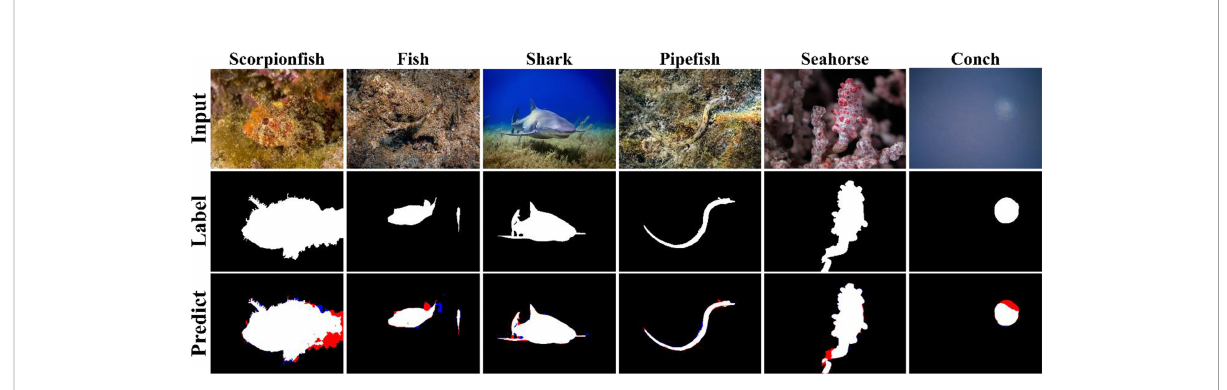
FIGURE 6 Result images of PSS-Net with MAS3K dataset (case 2). TP, FP, FN, and TN are expressed in white, blue, red, and black,